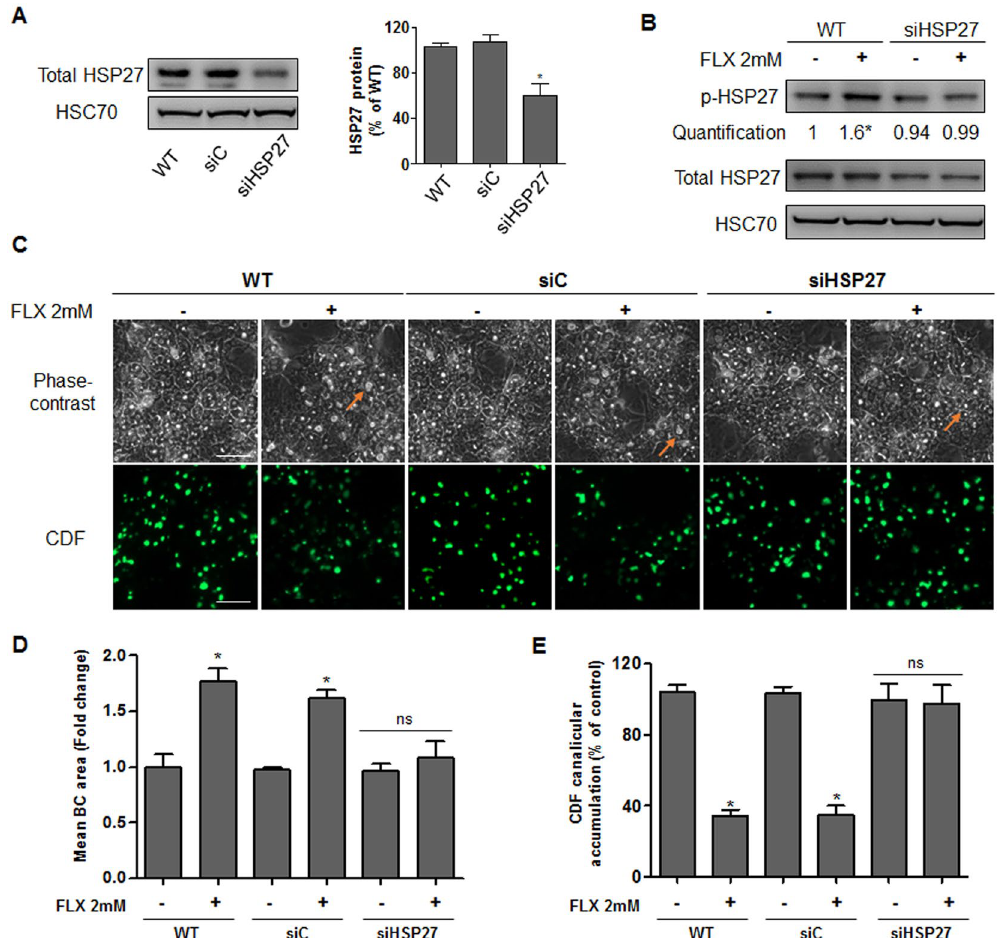
Figure 5. FLX effects in siHSP27-transfected cells. ( A ) Representative western blots of total HSP27 and HSC70 after 72 h in HepaRG cells: wild type (WT), transfected with scramble siRNA (siC) and HSP27 siRNA (siHSP27). Quantification of total HSP27 using ImageJ 1.48 software. ( B ) Representative western blots of the p-HSP27/total HSP27 forms and HSC70 after 2h-treatment with 2 mM FLX in WT and siHSP27 transfected HepaRG cells. The displayed blots were cropped and the original full-length gels are included in the supplementary information. ( C ) Representative phase-contrast images and CDF efflux in wild type, siC and siHSP27 transfected HepaRG cells treated with 2 mM FLX (bar = 50 μ m). ( D ) Quantification of the BC area and ( E ) canalicular CDF accumulation in HepaRG cells after 2 h of FLX treatment using ImageJ 1.48 software. Data were expressed relative to those of the untreated cells arbitrarily set at a value of 1 or 100%. They represent the means ± SEM of 3 independent experiments. * p < 0.05 compared with that of untreated